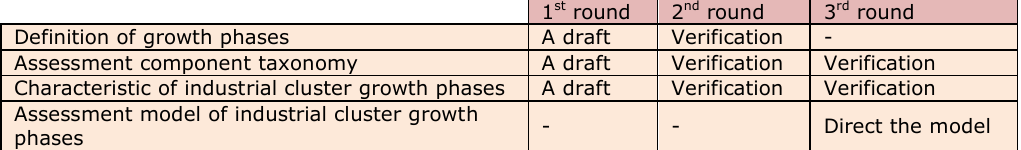
Table 4. The steps of Delphi Method in this